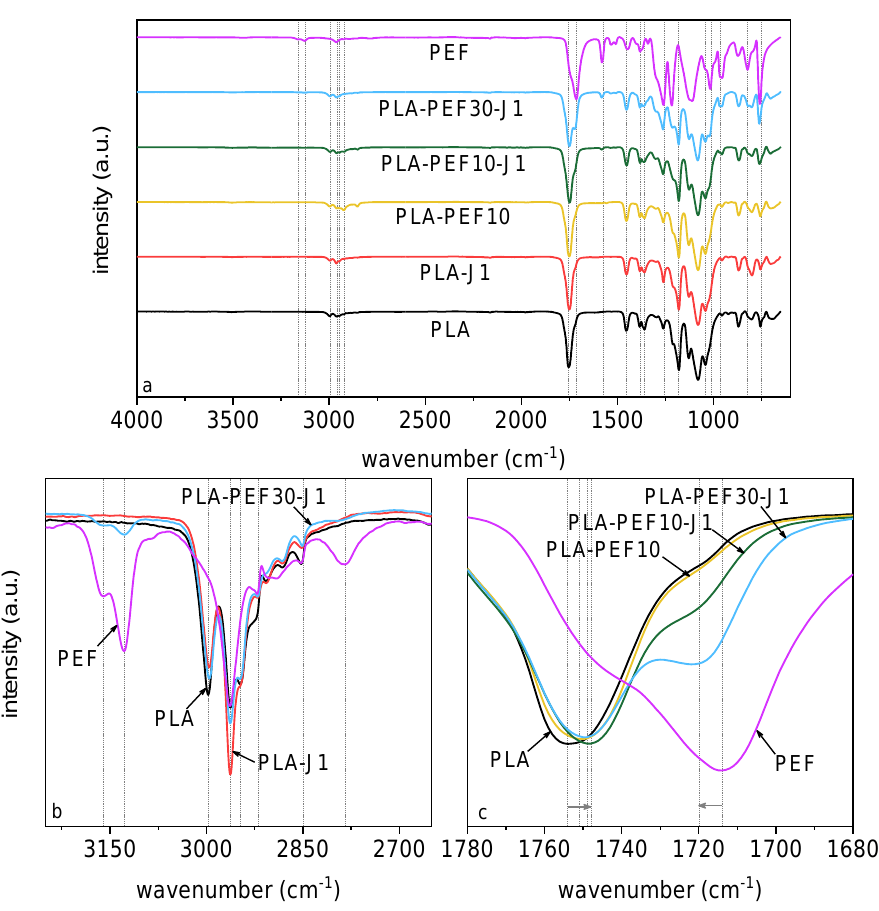
Figure 4. Results of the FT-IR analysis on some selected compositions. ( a ) Full spectrum; ( b , c ) highlights of some specific regions. Table 2. Results of FT-IR analysis. Band position (cm −1 ) and assignment of the main signals from the sample PLA, PEF, and PLA-PEF10.